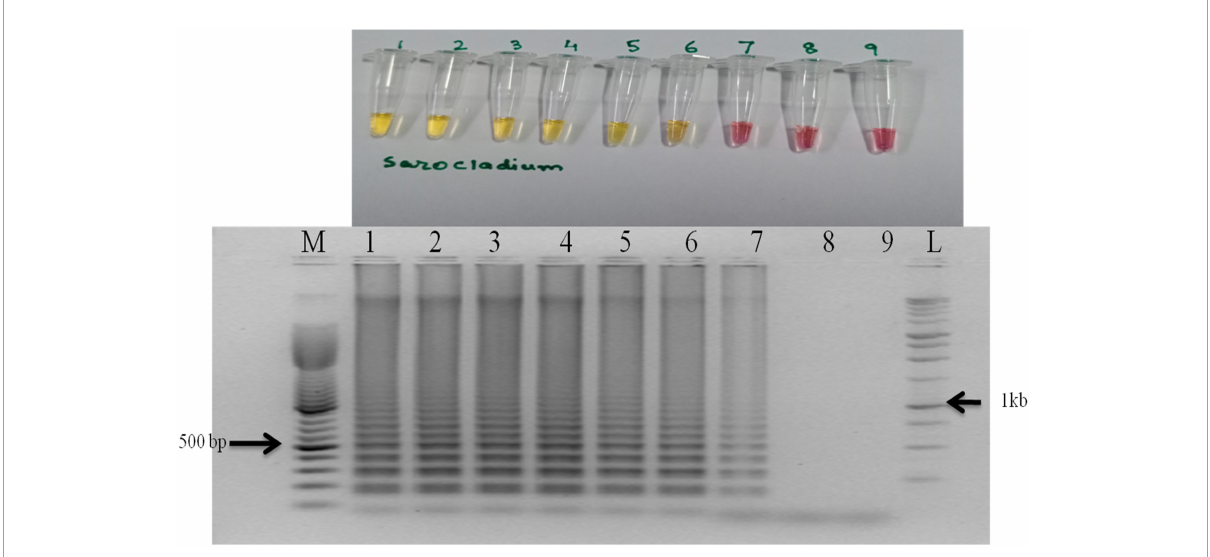
FIGURE3 Sensitivity of the LAMP assay when performed with 10-fold serial dilution of template DNA ( S. oryzae NAIMCC-F-01630). M: 100 bp (Promega); 1: 160.4 ng/ µ l; 2: 160.4 × 10 − 1 ng/ µ l; 3: 160.4 × 10 − 2 ng/ µ l; 4: 160.4 × 10 − 3 ng/ µ l; 5: 160.4 × 10 − 4 ng/ µ l; 6: 160.4 × 10 − 5 ng/ µ l; 7: 160.4 × 10 − 6 ng/ µ l; 8: 160.4 × 10 − 7 ng/ µ l; 9: No template control; and L: 1 kb (Promega). Upper panel in the figure shows reaction tubes whereas lower panel shows agarose gel electrophoresis results.